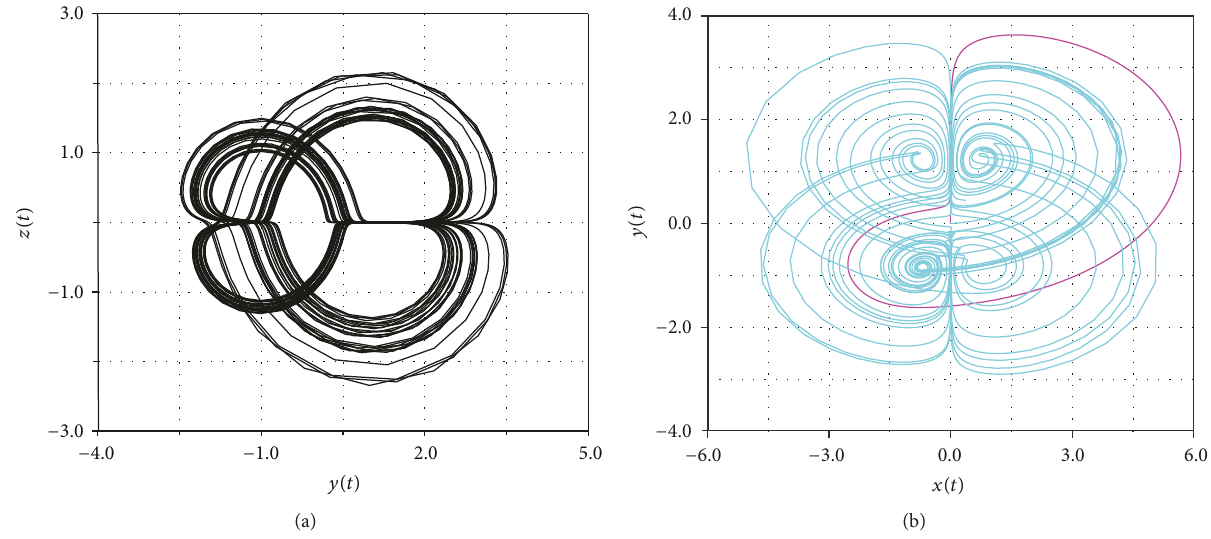
Figure 7: Circuit simulation diagrams: (a) y - z phase diagram and (b) x - y coexistence phase